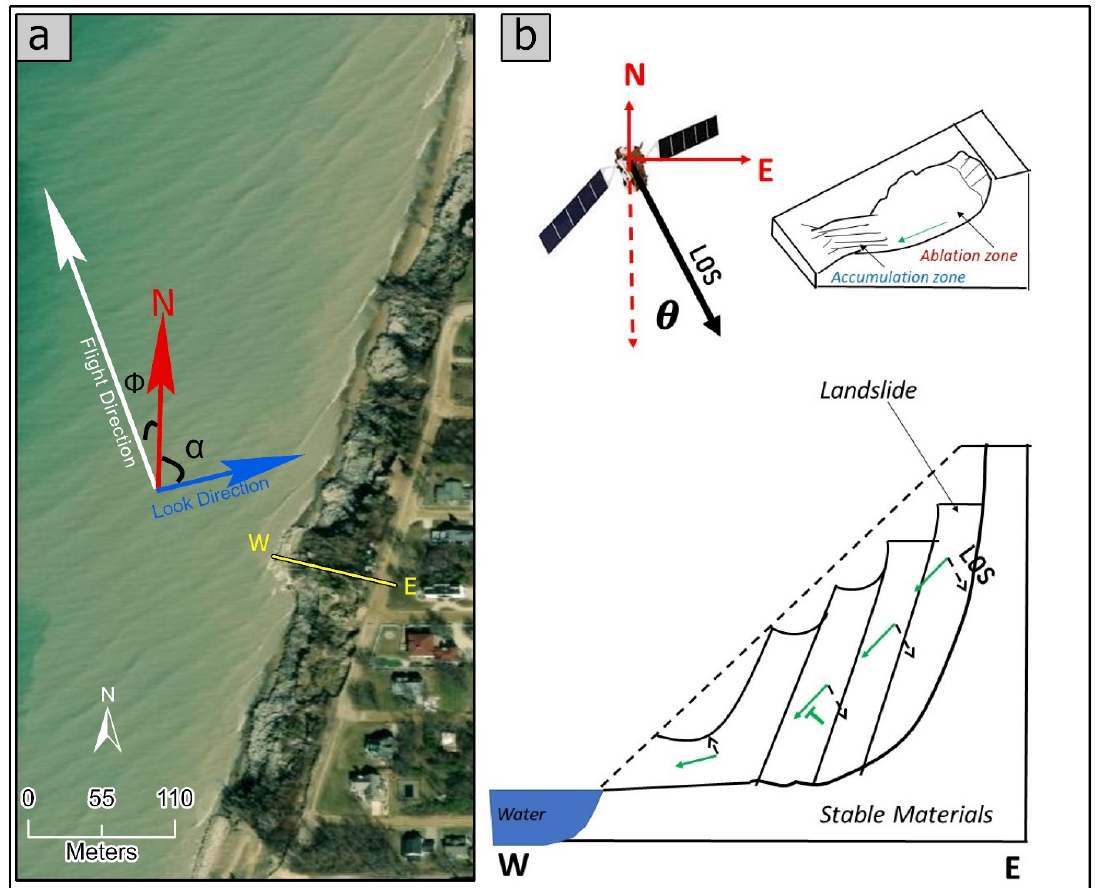
Figure 2. ( a ) Satellite flight ( Φ ~10.4°) and look direction ( α ~79.6°) with respect to the bluff’s slope orientation (N80W–S80E) plotted over an ArcGIS pro base map. The solid red arrow represents the geographic north direction, the solid white arrow represents the satellite flight direction, and the solid blue arrow represents the satellite look direction (orthogonal to flight direction). ( b ) Schematic cross ‐ section along slope direction shows the bluff slope and its ablation and accumulation zones with respect to the satellite LOS. The solid green lines represent the displacement vector T along the slip surface, and the black dashed arrows the displacement vector T along the LOS direction. The incidence angle is represented by θ (~40). Source of base map: Esri, DigitalGlobe, GeoEye, i ‐ cubed, USDA FSA, USGS, AEX, Getmapping, Aerogrid, IGN, IGP, swisstopo, and the GIS User Commu ‐ nity.